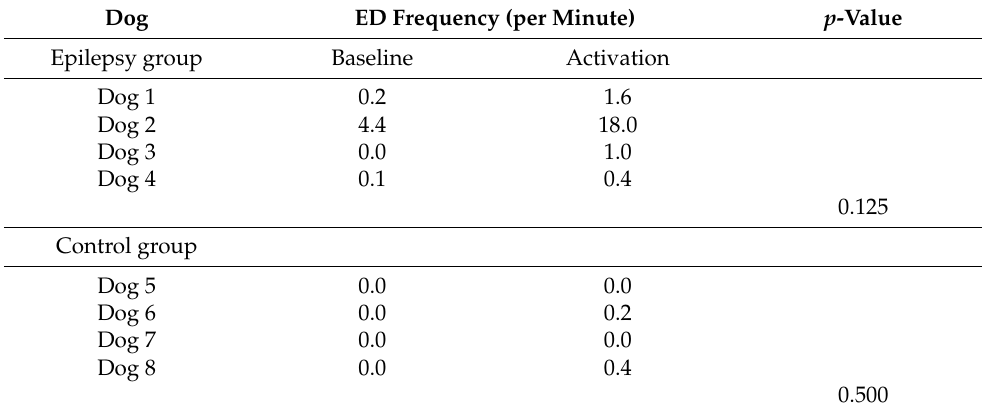
Table 5. Comparison of ED frequencies between baseline and activation periods in each dog. Dog ED Frequency (per Minute) p -Value Epilepsy group